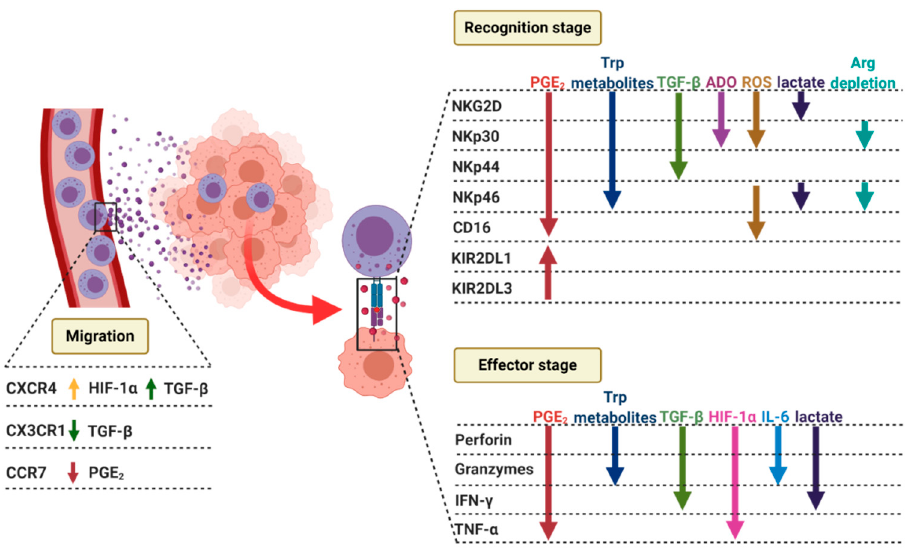
Figure 4. Tumor microenvironment shapes NK cells’ migration to the tumor site by upregulation of CXCR4 receptor through HIF-1 α and TGF- β . It also downregulates CX3CR1 expression by TGF- β and CCR7 levels by PGE 2 , thus limiting their recruitment to the tumor sites. The formation of NK-cell lytic synapse can be divided into recognition, effector and termination stages. Within the tumor microenvironment factors such as PGE 2 , tryptophan metabolites, TGF- β , ADO, ROS, and lactate can downregulate NK cells activating receptors, including NKp46, NKp44, NKp30, and CD16 and inhibitory receptors, such as KIR2DL1 and KIR2DL3. On the other hand, during the effector stage, the same metabolites can decrease expression of the lytic granule molecules, such as perforin and granzymes. Also, they can influence NK cells’ ability for cytokine production, including IFN- γ and TNF- α .